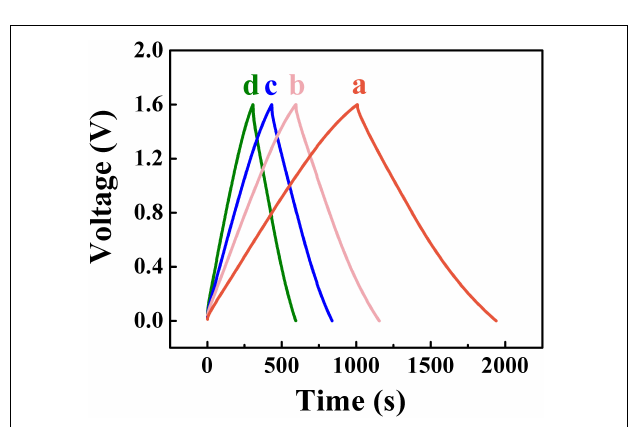
FIGURE 10 | Galvanostatic charge-discharge curves at current densities of (a) 3, (b) 5, (c) 7, (d) 10 mA cm − 2 for asymmetric supercapacitor cell.